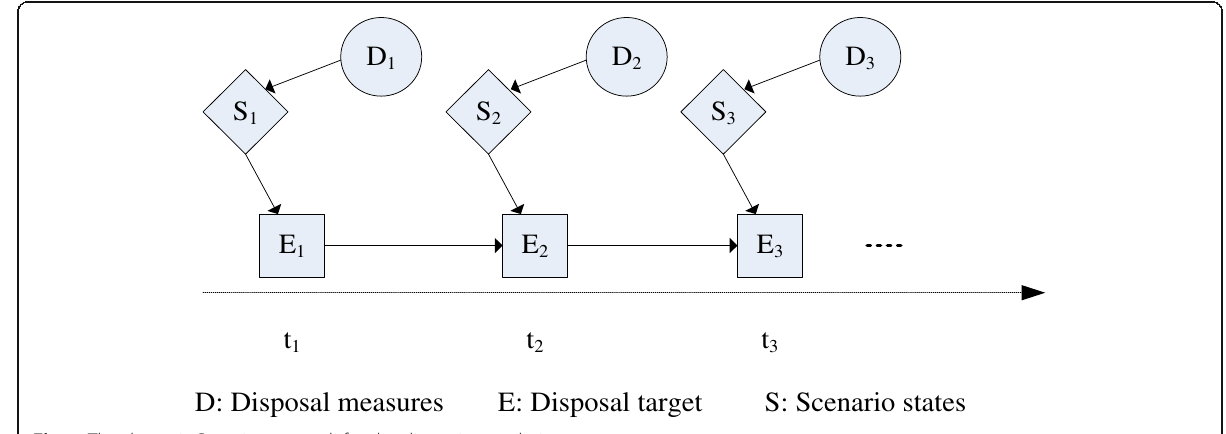
Fig. 4 The dynamic Bayesian network for the disruption evolution